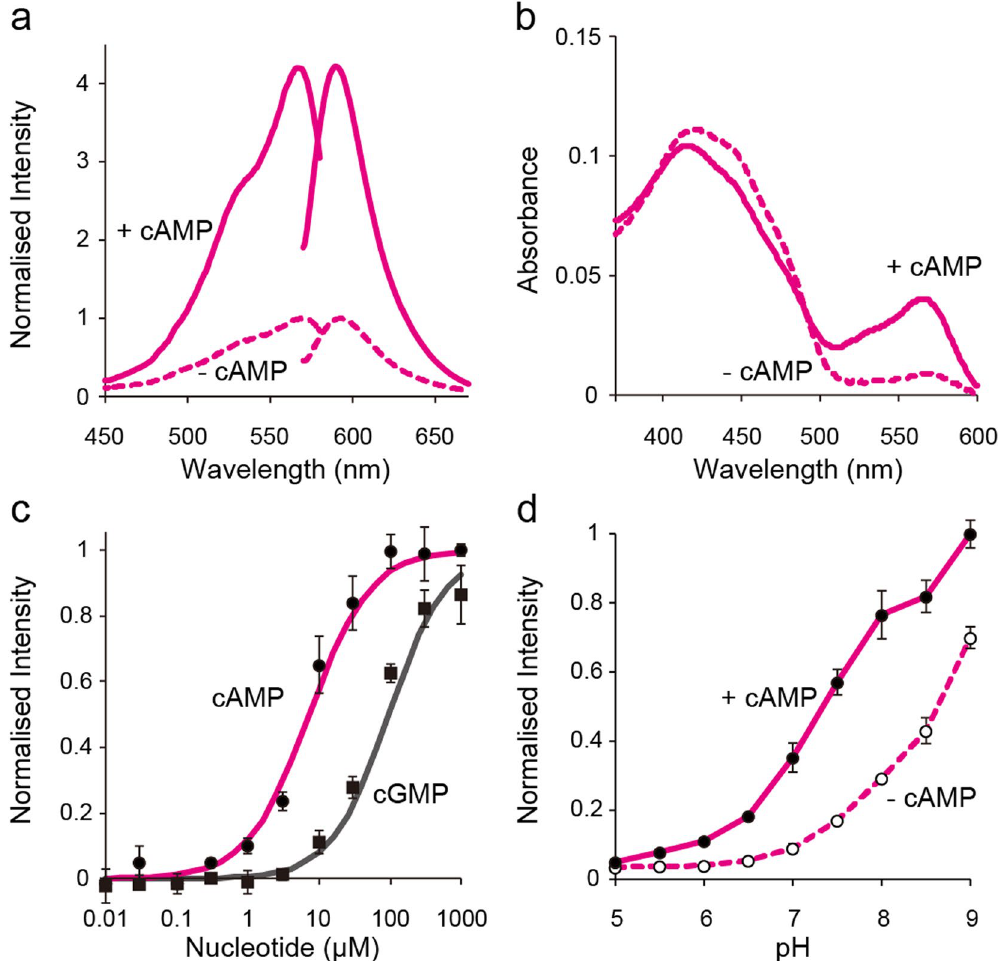
Figure 2. Spectroscopic characterisation of Pink Flamindo. ( a ) Excitation and emission spectra of purified Pink Flamindo protein in the presence (solid line) or absence (dashed line) of 100 μ M cAMP. Each fluorescent intensity (FI) was normalised to the peak of FI in the absence of cAMP. ( b ) Absorbance spectra of 30 μ M Pink Flamindo in the presence (solid line) or absence (dashed line) of 100 μ M cAMP. ( c ) Dose-response curve of Pink Flamindo for cAMP ( ● , red line) and cGMP ( ■ , gray line). K d values calculated using the Hill equation were 7.2 μ M for cAMP and 94 μ M for cGMP. The peak of FI in the absence of cAMP or cGMP was normalised to 0, and the peak of FI in the presence of 1 mM cAMP was normalised to 1. The data represent the means ± standard deviation (n = 3). ( d ) Titration curves of Pink Flamindo against pH in the presence ( ● , solid line) or absence ( ○ , dashed line) of 100 μ M cAMP. The peak FI for each pH was normalised to the peak of FI in the presence of cAMP at pH 9.0. The data represent the means ± standard deviation (n =